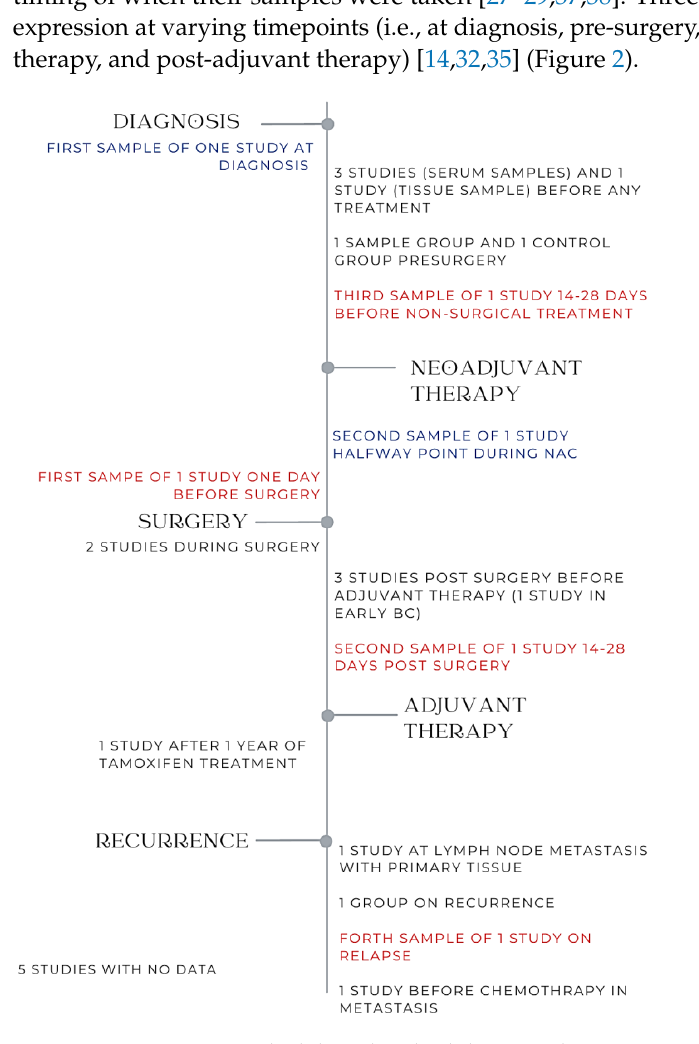
Figure 2. Timepoints at which liquid and solid tumour biopsies were obtained.